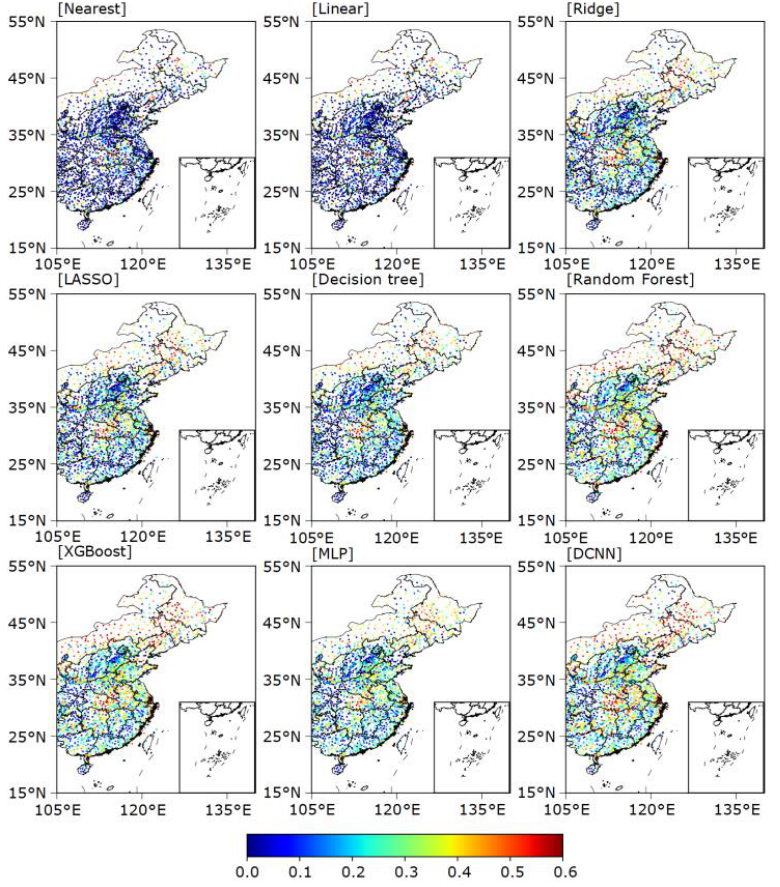
Figure 6. Spatial distribution of R 2 values for summer wind speeds across eastern China estimated by different interpolation methods.